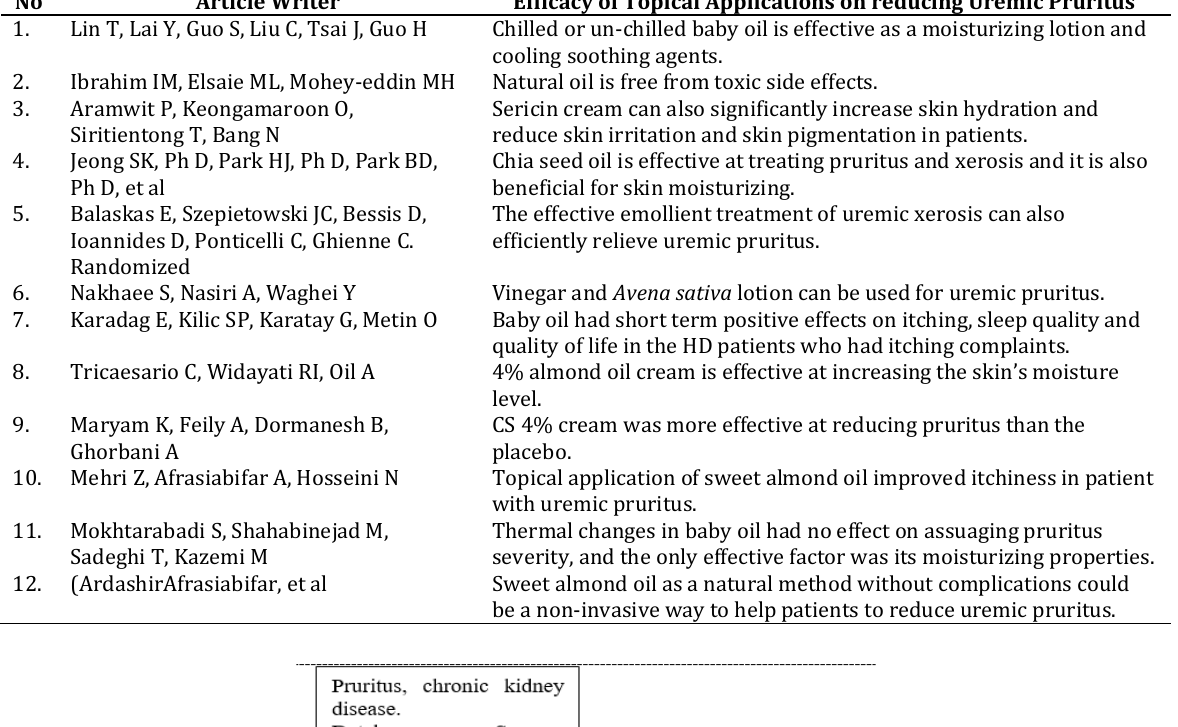
Table 1. List the Efficacy of Topical Applications on reducing Uremic Pruritus